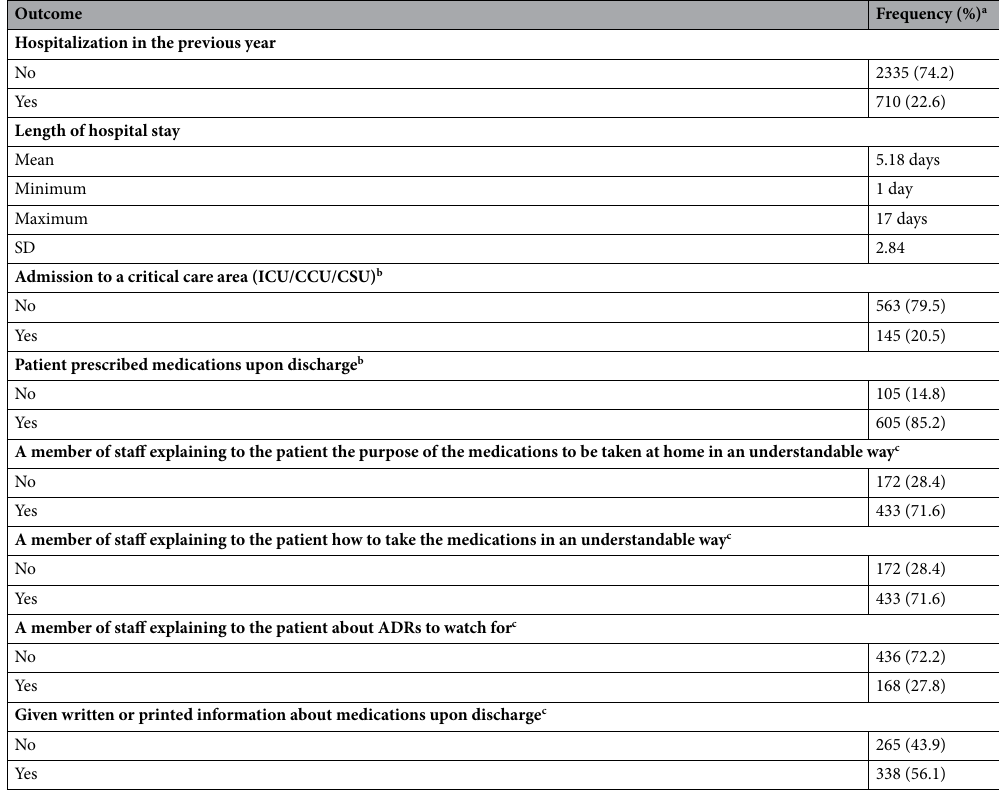
Table 6. Hospitalization in the previous year. a Sometimes the cumulative percentages may not reach 100% due to missing values. When missing values are less than 10%, they were not reported explicitly. b Total number of participants on the marked questions is 710, referring to the patients who were hospitalized during the last year. c Total number of participants on the marked questions is 605, referring to the patients who were prescribed medications upon hospital